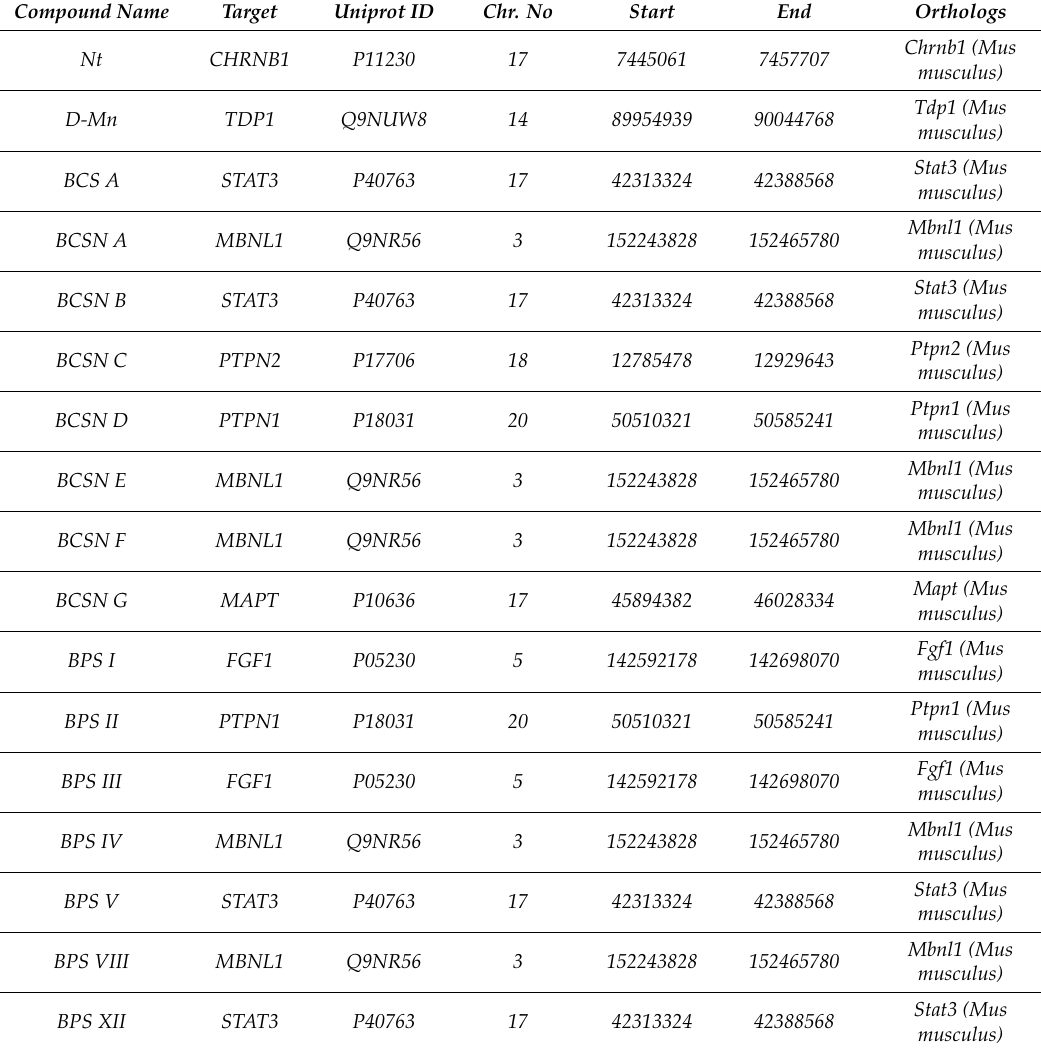
Table 2. Features of human active